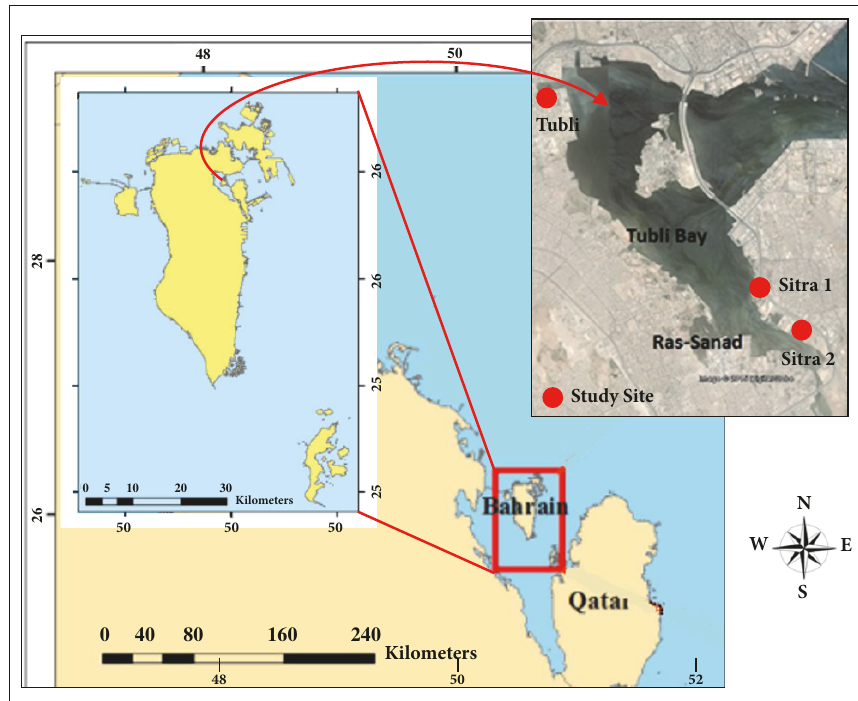
Figure 2: Locations of study